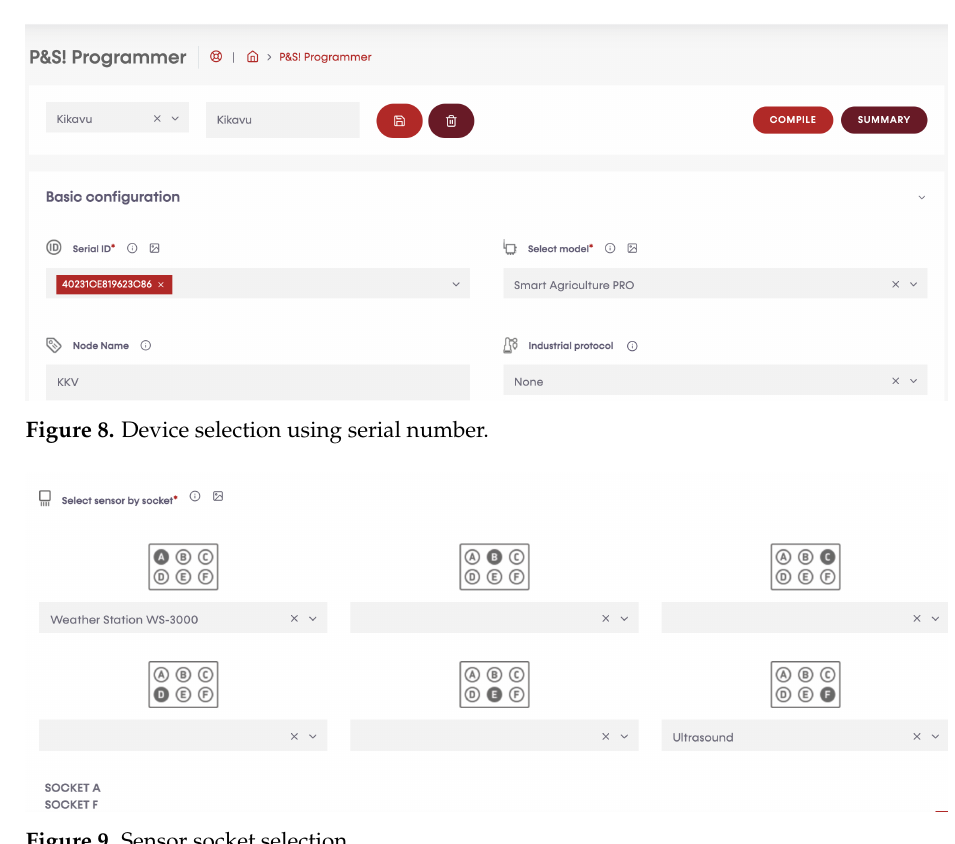
Figure 9. Sensor socket